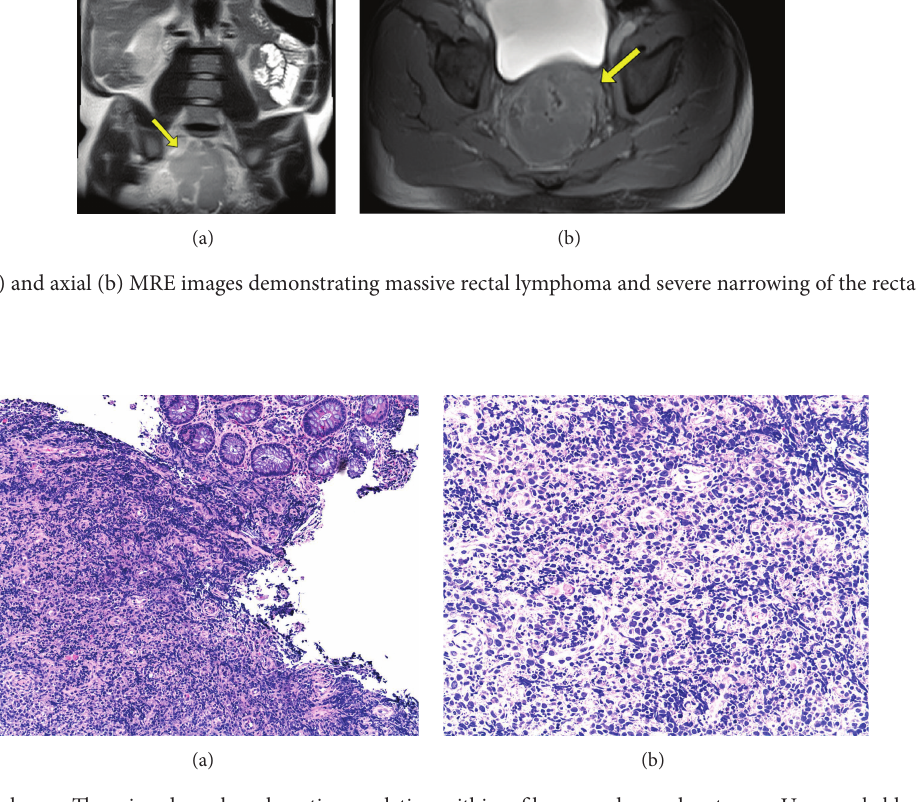
Figure 4: Rectal lymphoma. There is a dense lymphocytic population within a fibrous and vascular stroma. Unremarkable colonic mucosa can be seen in the upper right hand side (10x) (a). The population consists of atypical medium to large lymphocytes with prominent nucleoli and immature chromatin. There are scattered plasma cells and mature lymphocytes present (20x)